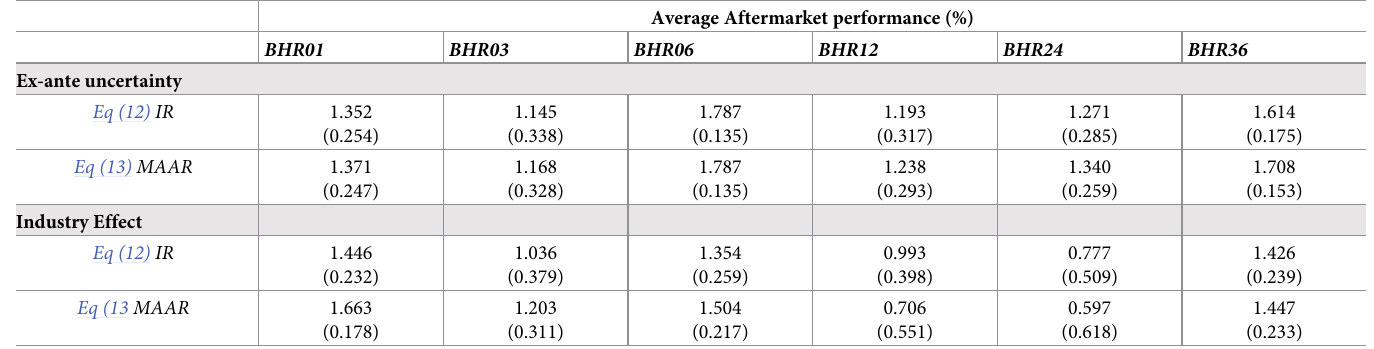
Table 10. Wald test